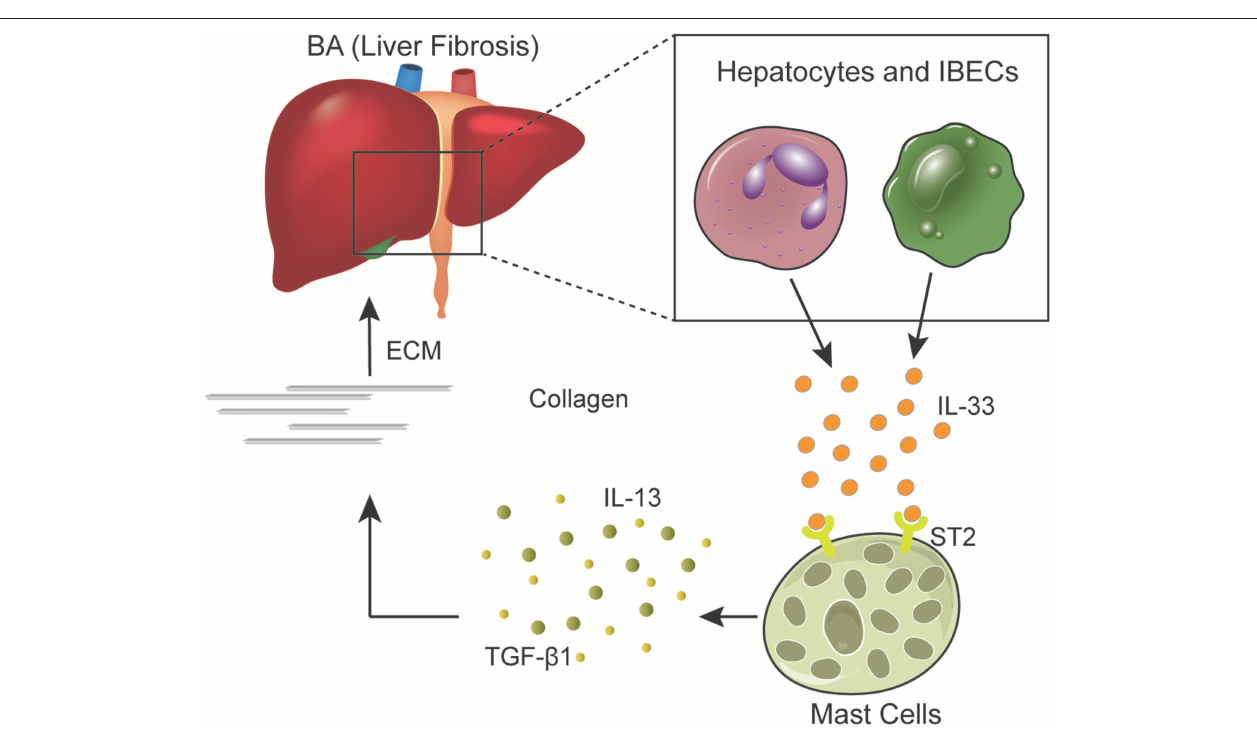
FIGURE 6 | IL-33/ST2 signaling axis. IL-33 is secreted mostly by hepatocytes and intrahepatic biliary epithelial cells in the liver. After combining with ST2 receptor expressed on mast cells and other cells, IL-33 induces mast cells to release inflammation and fibrotic cytokines such as IL-13 and TGF- β 1. IL-13 and TGF- β 1 mediates the production of collagen and extracellular matrix, which could contribute to liver fibrosis in BA patients. BA, biliary atresia; IBECs, intrahepatic biliary epithelial cells; ECM, extracellular